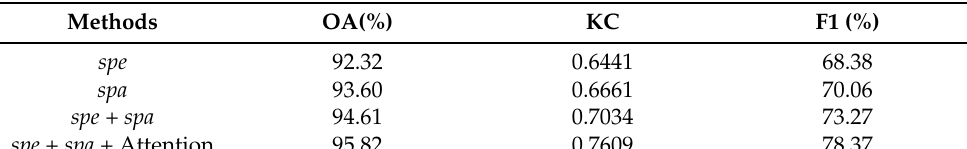
Table 1. Quantitative comparison for ablation study of the combination of different features on the River dataset.